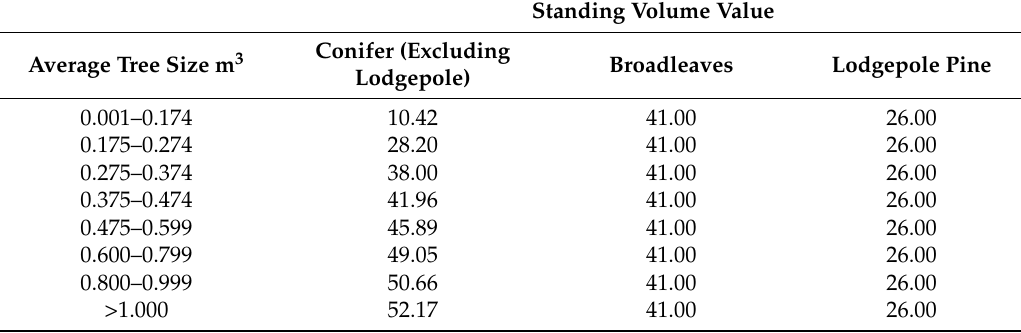
Table A2. Value of standing volume (in € m − 3 ) used in the model, based on average tree size for conifers (excluding lodgepole pine), and fixed values for broadleaves and lodgepole pine. Source: Teagasc [58] and Coillte.